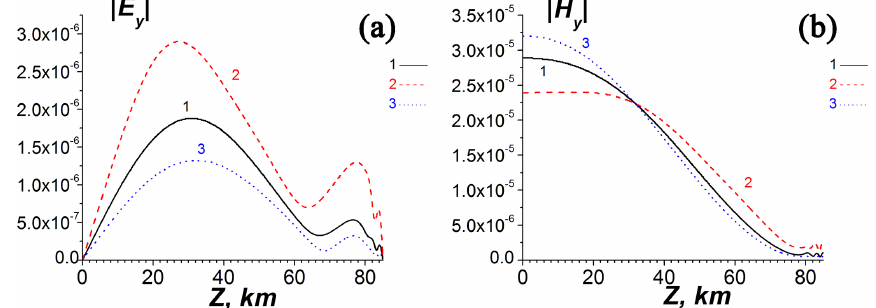
Figure 7. The dependencies of EM components at altitude z in the center of the waveguide at y = 1500km for the different profiles of the electron concentration. The solid (1), dashed (2) and dotted (3) curves correspond to the different profiles of the electron concentration in Fig. 5. Panels (a) and (b) are the same kinds of curves, with ω = 1 . 0 × 10 5 s − 1 and θ = 45 ◦